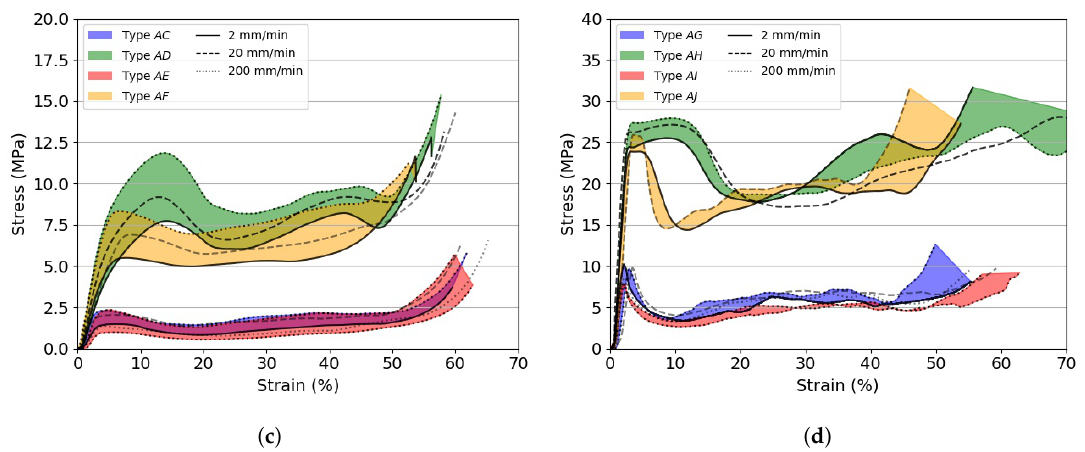
Figure 5. Compressive stress vs. strain curves for the investigated 3D printed specimens tested at different cross-head displacement rates. ( a ) 3D printed ABS; ( b ) 3D printed CPE; ( c ) 3D printed PA; ( d ) 3D printed PLA.